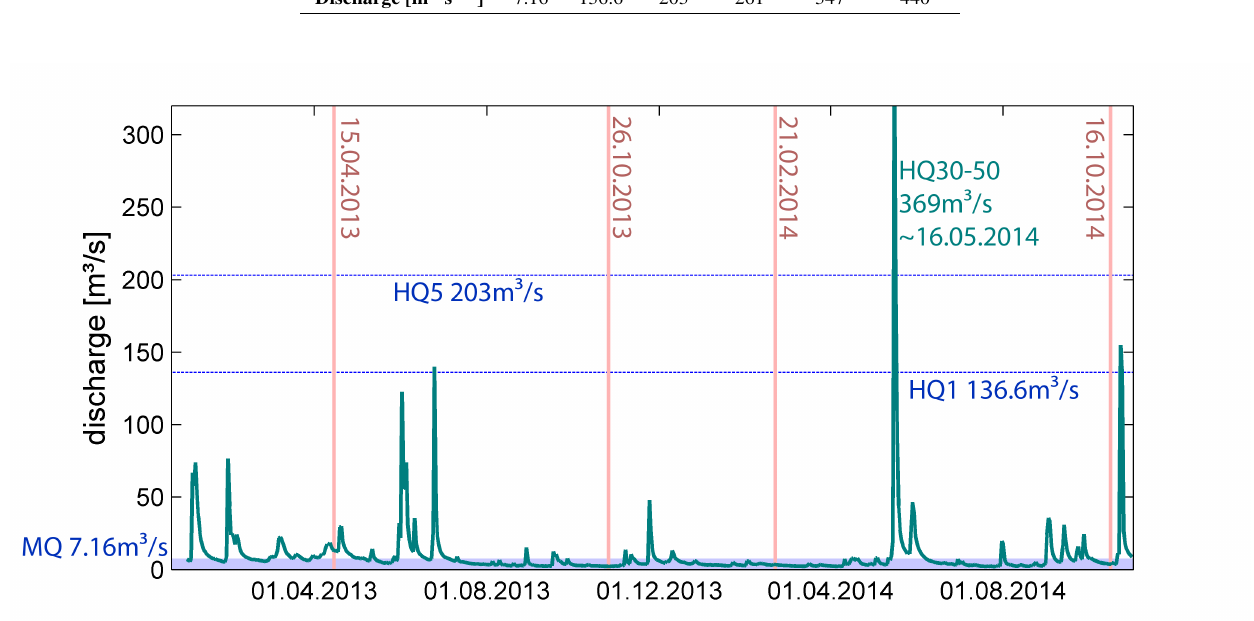
= flood discharge for n